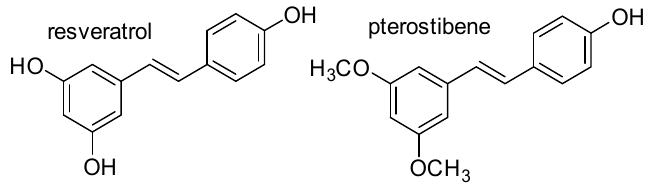
Figure 1. Resveratrol and pterostilbene.